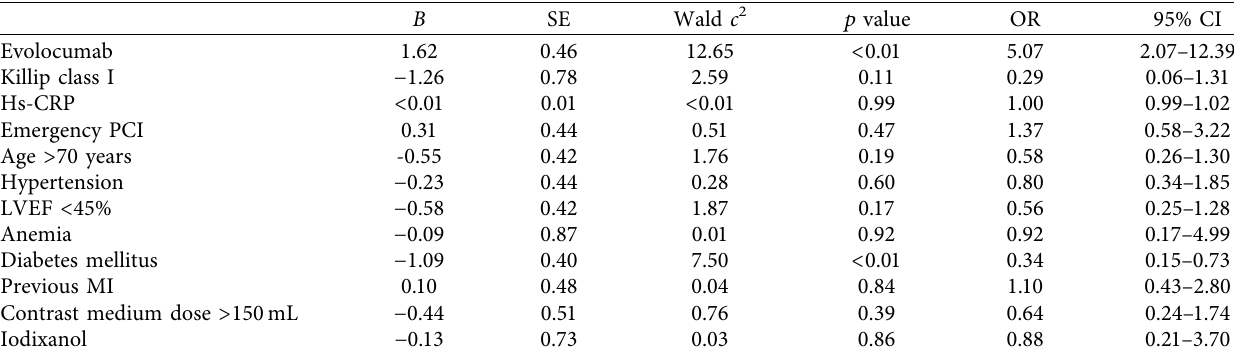
Table 4: Logistic regression analysis of patients with acute myocardial infarction undergoing coronary intervention ( n �